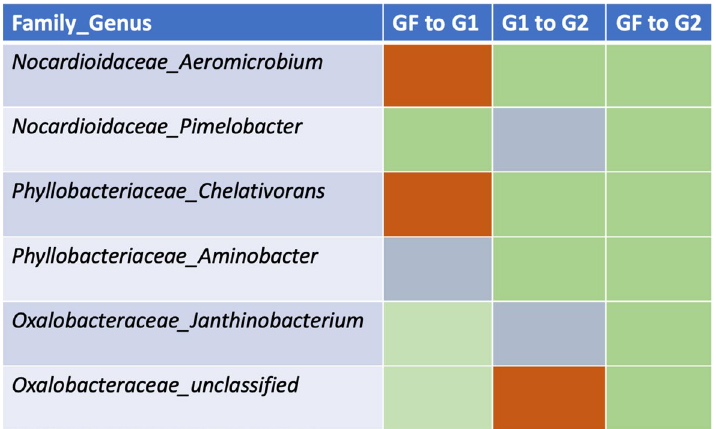
Table 1. Bacterial taxa, to the genus level, which showed differing abundances when comparing inoculated treatment groups from different generations. GF signifies microbial community membership from the initial soil slurry used to inoculate the first generation. G1 and G2 represent generation 1 and generation 2, respectively. Green boxes represent a significant increase in abundance and red boxes represent a significant decrease in abundance. Gray boxes represent no significant differences in abundance between the two treatment groups. The two generational treatments used in a comparison are identified at the top of each